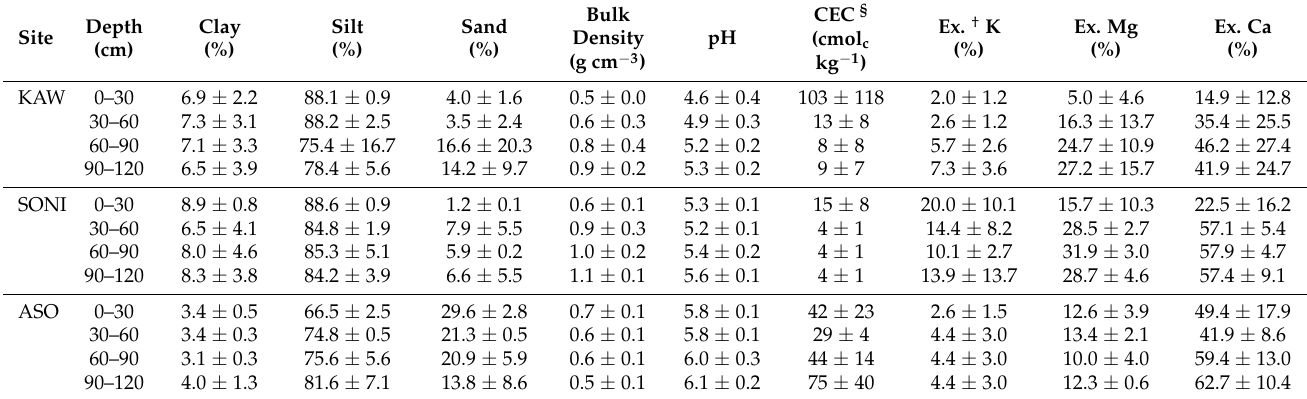
Table 1. Soil physical and chemical properties (Average ± SD) underlying three Miscanthus sinensis grasslands in Japan (i.e., Kawatabi Field Science Center, Miyagi Prefecture (KAW); Soni Plateau, Nara